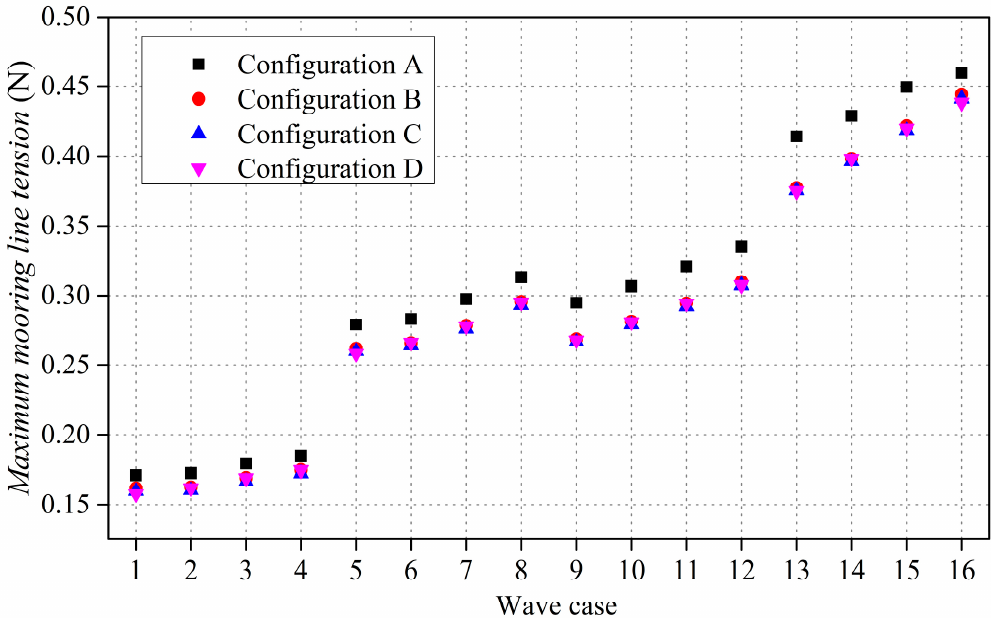
Figure 15. Maximum mooring line tension for Configurations A-D under waves and currents.